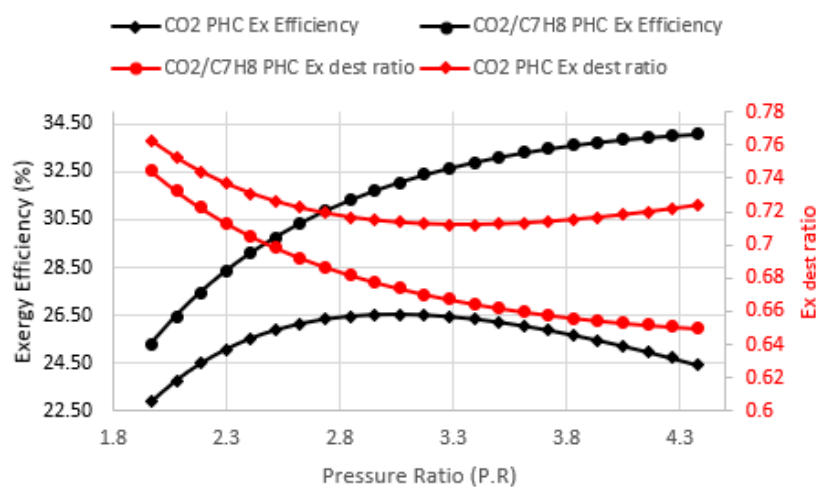
Figure 7. Exergetic efficiency and exergy destruction ratio of CO 2 PHC and 0.9CO 2 /0.1C 7 H 8 PHC concerning pressure ratio.